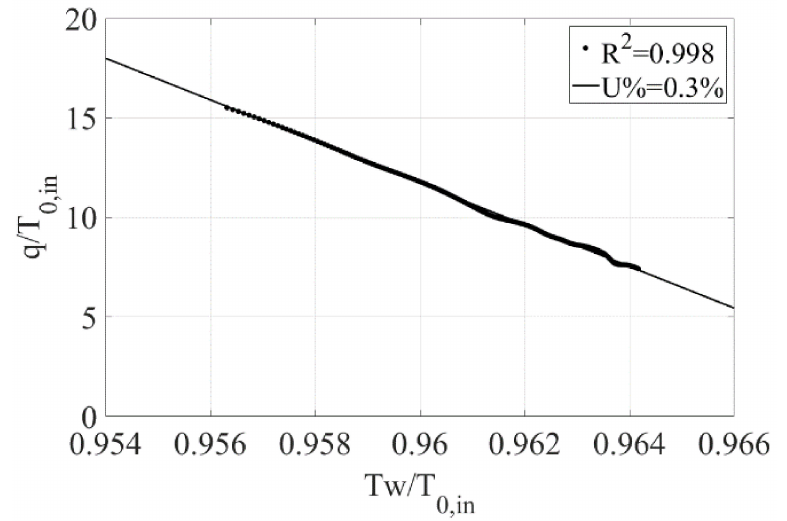
Figure 14. Linear relationship between heat flux and wall temperature for a selected point during one transient